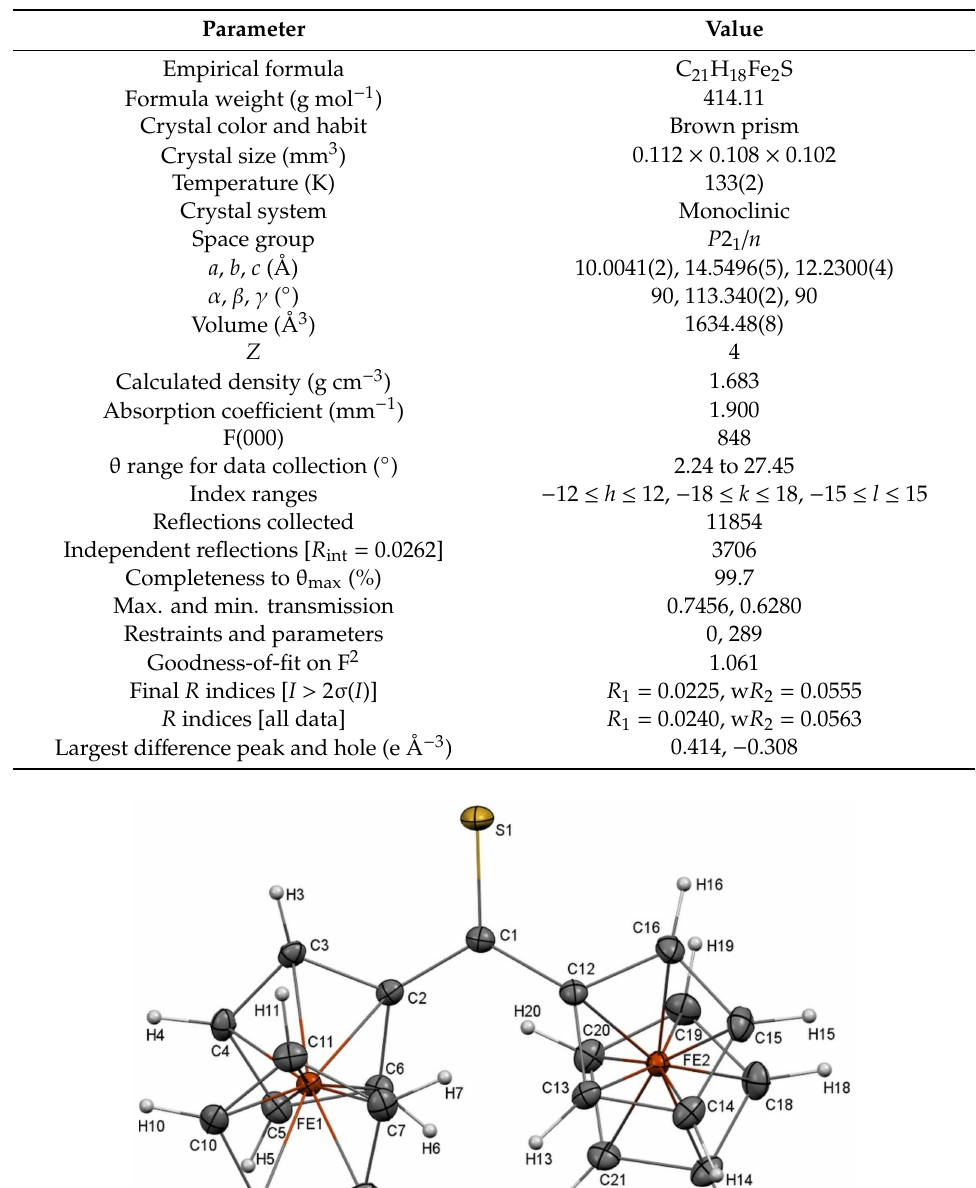
Table 1. Crystallographic data and refinement details for Fc 2 CS.